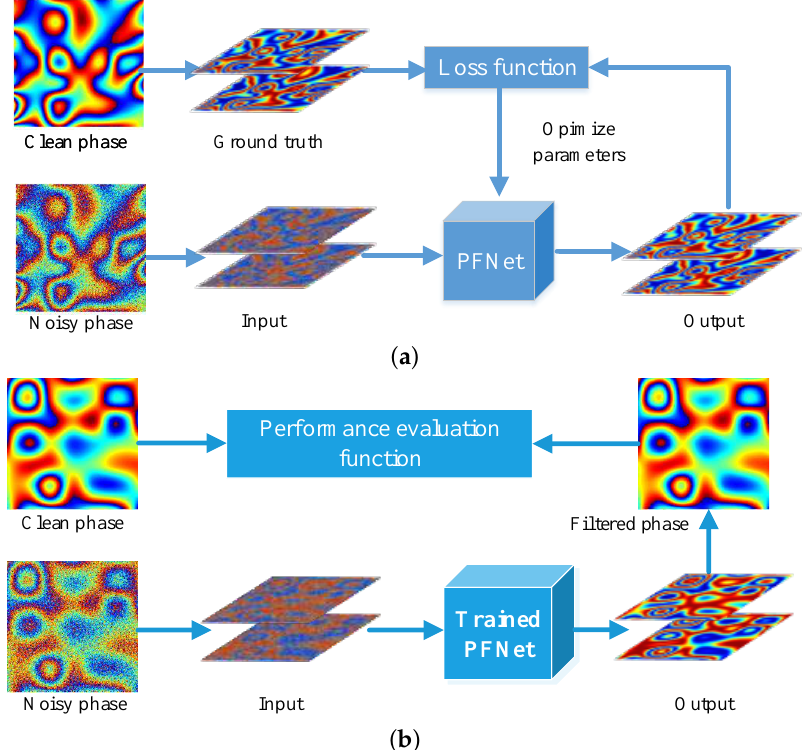
Figure 5. ( a ) Training and ( b ) testing process of the proposed method.